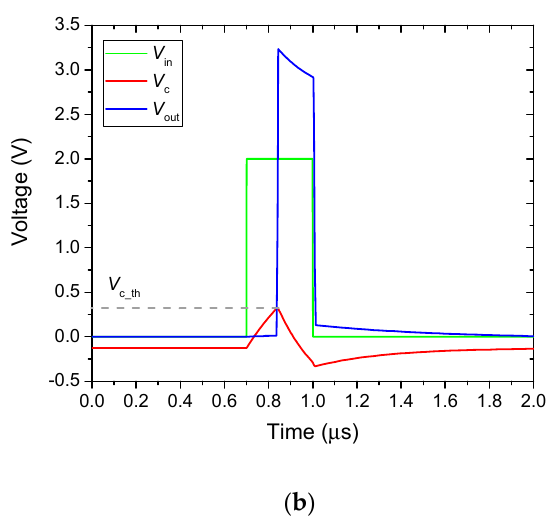
Figure 3. ( a ) An example of an electrical circuit of a VO 2 neuron activated by a voltage generator, and ( b ) oscillograms of voltages V in , V out , and V c illustrating the spikes’ dynamics.